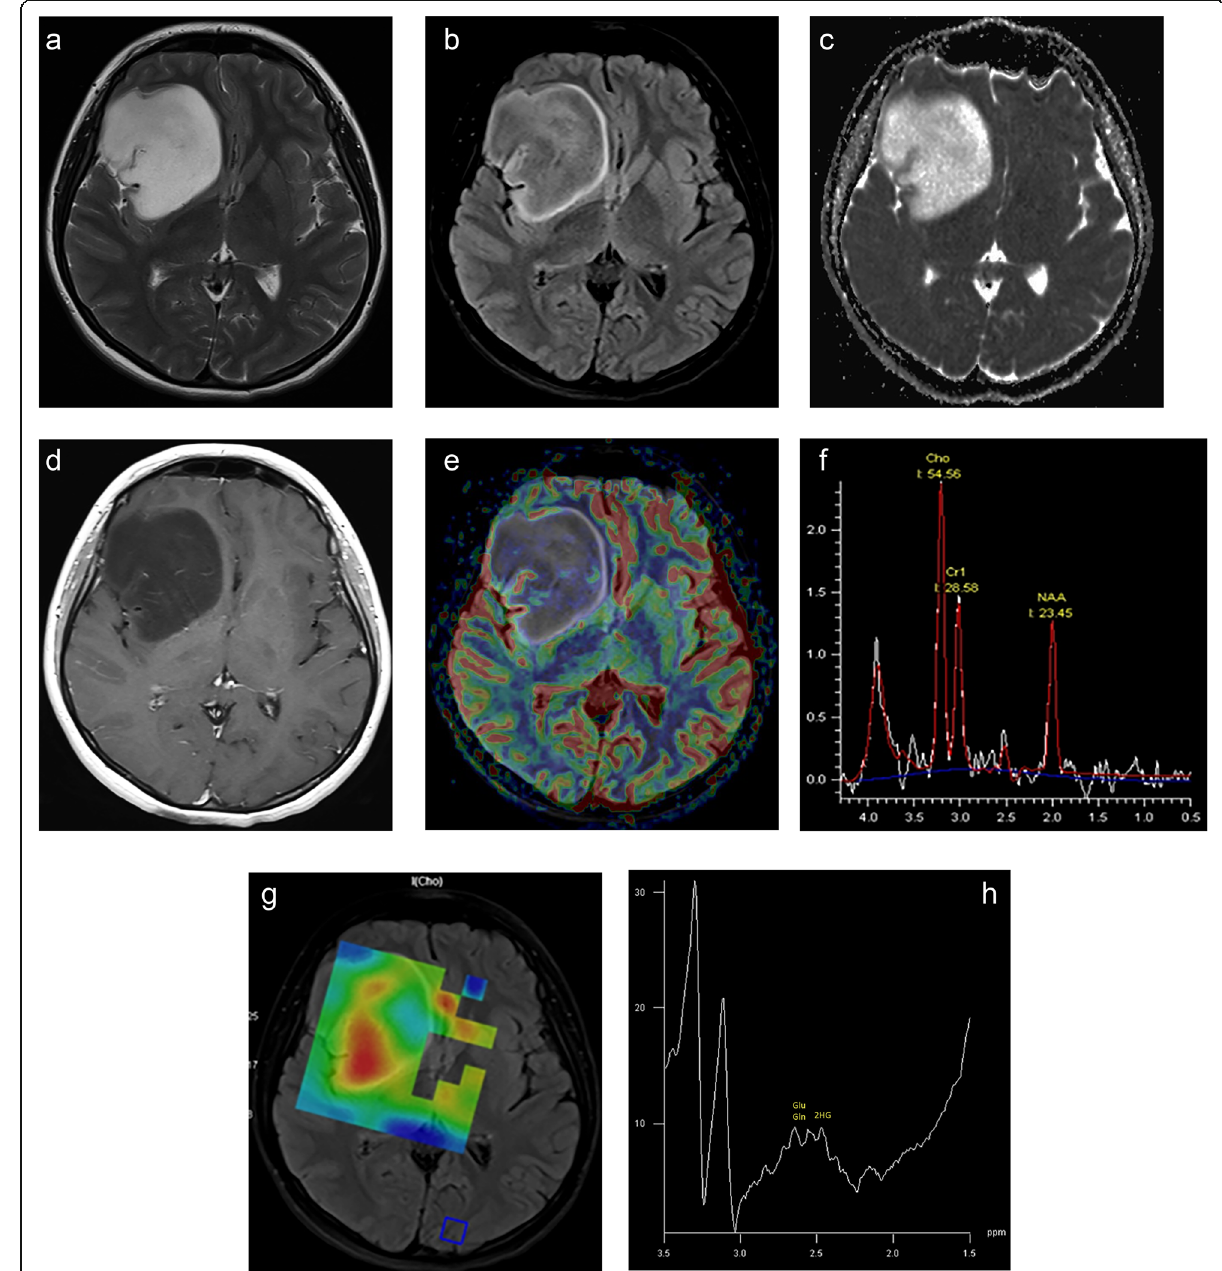
Fig. 1 Grade II astrocytoma with IDH1 mutation, 30% p53, and 3% Ki67 is located on the posterior aspect of the right frontal lobe on axial MR images. There is a mismatch sign on T2 ( a ) and FLAIR ( b ) images. The tumor has a high signal on ADC ( c ) images and does not enhance on post-contrast T1-weighted image ( d ). The tumor has low rCBV max values compared to normal parenchyma on the DSC-perfusion image ( e ). Increased Cho/Cr ratio inside the tumor borders is prominent on both the MR spectrum obtained by 144 ms echo time ( f ) and colored Cho map ( g ). The high-resolution MR spectroscopy by 69 ms of echo time ( h ) reveals the 2-HG peak causing a triplet within the glutamine-glutamate complex (Glu-Gln), which is consistent with the existence of IDH1